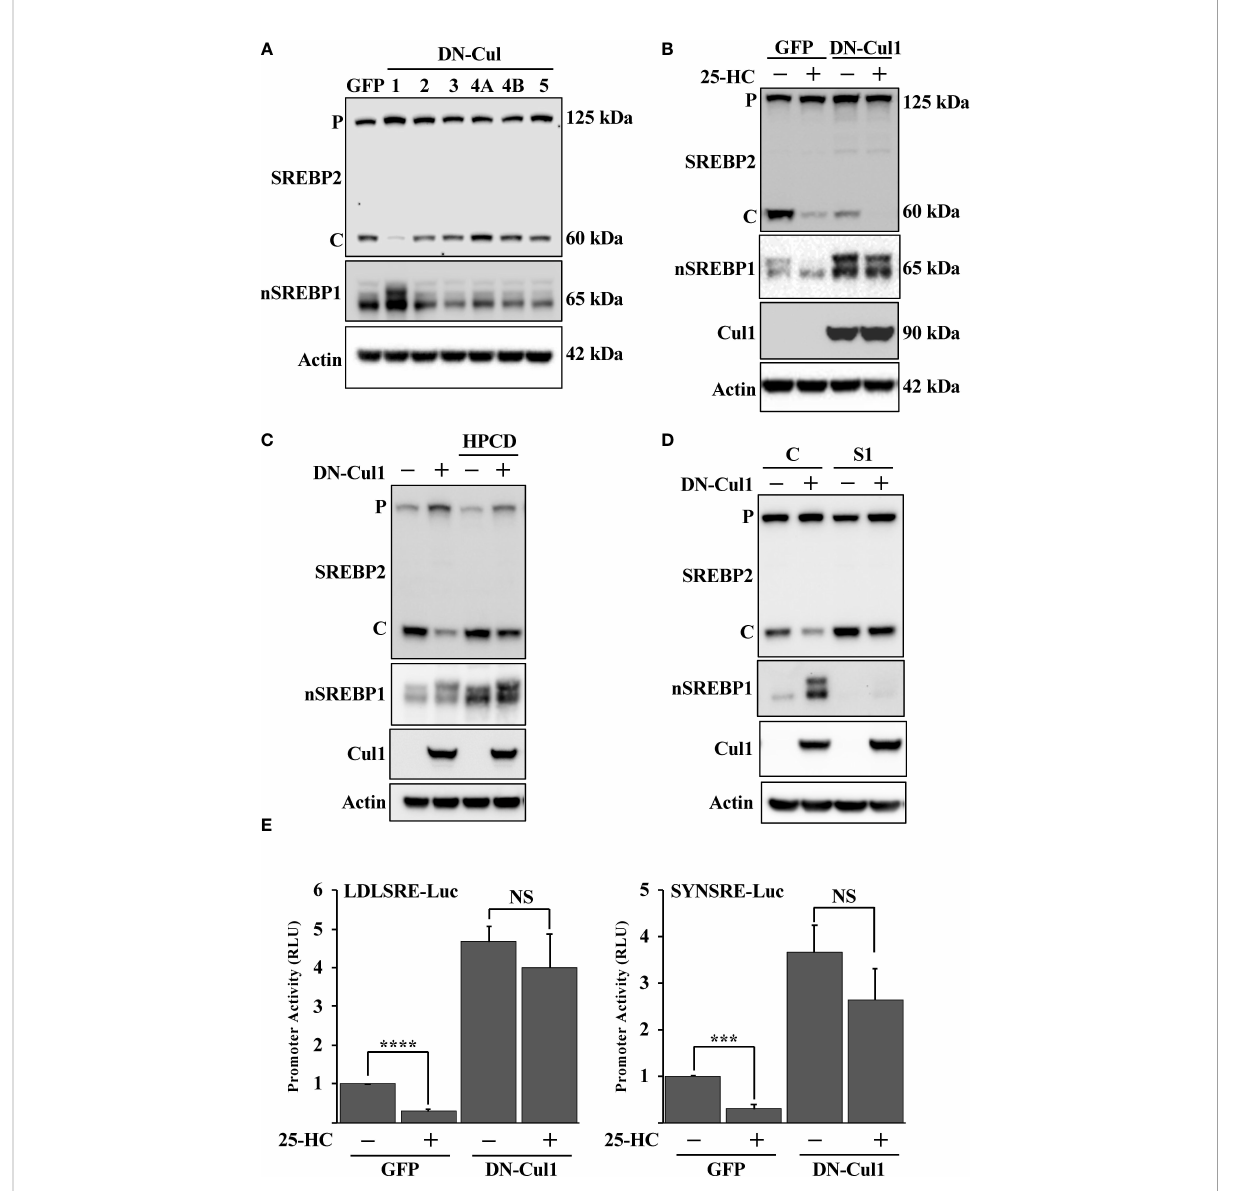
FIGURE 1 Cullin 1 regulates the maturation of SREBP2. (A) HepG2 cells were transduced with lentiviruses expressing the indicated dominant-negative (DN) cullins (cullin 1, 2, 3, 4A, 4B and 5). The levels of SREBP2, nuclear SREBP1 ( nSREBP1 ) and b -actin in total lysates were determined by Western blotting. P and C denotes the precursor and cleaved forms of SREBP2, respectively. (B) HepG2 cells were transduced with GFP or DN-cul1 lentiviruses, and left untreated or treated with 25-hydroxycholesterol (25-HC, 1.5 m g/ml) for six hours. The levels of SREBP2, nuclear SREBP1 ( nSREBP1 ), cullin 1 ( Cul1 ) and b -actin in total lysates were determined by Western blotting. P and C denotes the precursor and cleaved forms of SREBP2, respectively. (C) HepG2 cells were transduced with GFP or DN-cul1 lentiviruses and left untreated or treated with 2-hydroxypropyl- b - cyclodextrin ( HPCD , 1% (w/v)) for two hours. The levels of SREBP2, nuclear SREBP1 ( nSREBP1 ), cullin 1 ( Cul1 ) and b -actin in total lysates were determined by Western blotting. P and C denotes the precursor and cleaved forms of SREBP2, respectively. (D) HepG2 cells were transduced with GFP or DN-cul1 lentiviruses, followed by either control ( C ) or SREBP1 ( S1 ) shRNA. The levels of SREBP2, nuclear SREBP1 ( nSREBP1 ), cullin 1 ( Cul1 ) and b -actin in total lysates were determined by Western blotting. P and C denotes the precursor and cleaved forms of SREBP2, respectively. (E) HepG2 cells were transfected with luciferase promoter-reporter constructs containing the SREBP-responsive portions of the human LDL receptor ( LDLSRE-Luc ) and HMG-CoA synthase ( SYNSRE-Luc ) promoters together with empty vector or DN-cul1. Where indicated, the transfected cells were treated with 25-HC for the last 3 hours of the experiment. At the end of the experiment, cells were lysed, and luciferase activity was measured. P-values lower than 0.05 were considered statistically signi fi cant. *P < 0.05, **P < 0.01, ***P < 0.001, and ****P < 0.0001. NS , not signi fi